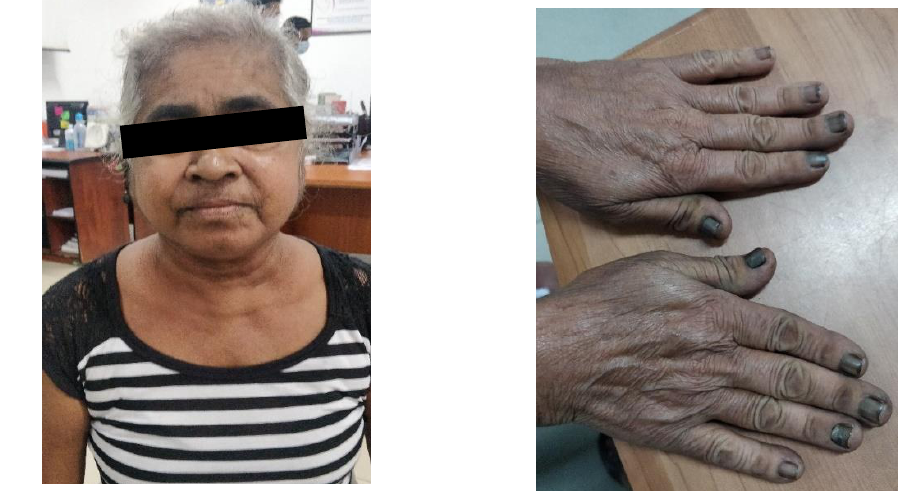
Figure 1: Patient’s external appearance and pigmented